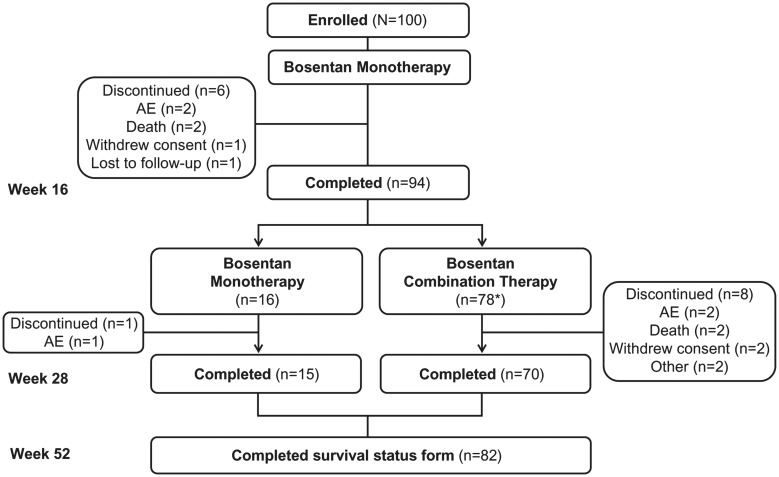
Patient disposition. *Two patients withdrew consent before dosing. Thus, only 76 patients received combination treatment. AE, adverse event.